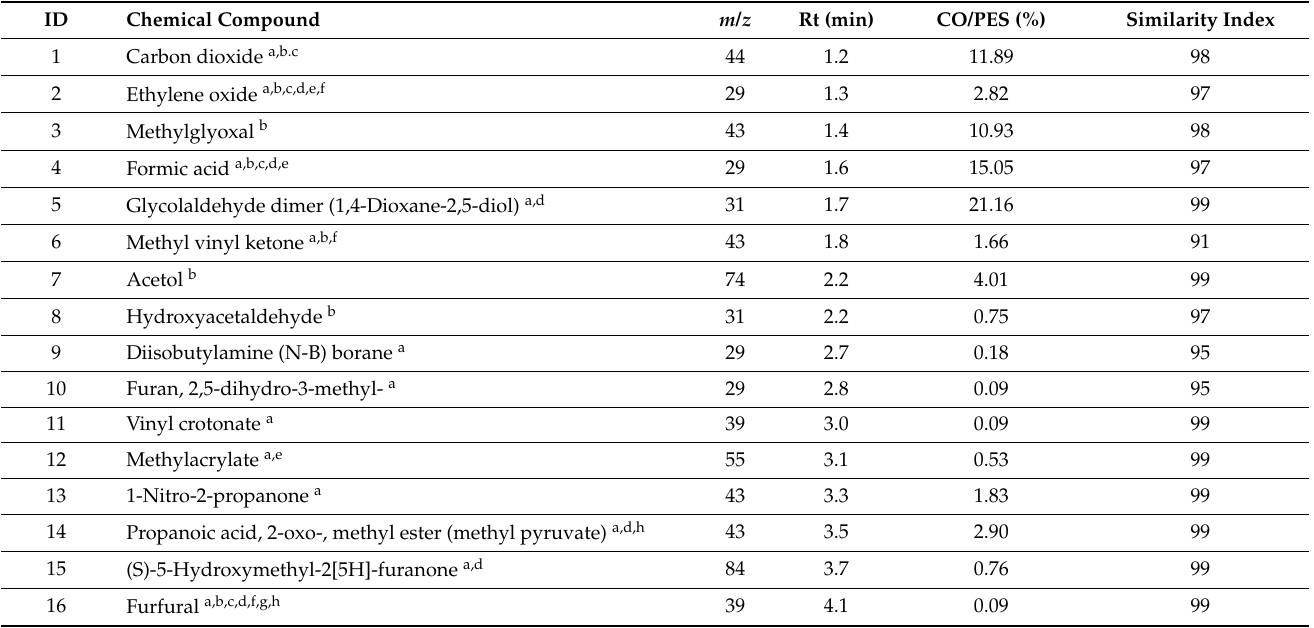
Figure 6. Chromatogram of cotton cellulose (weft yarn). Table 5. Pyrolytic products and quantitative indicators of the CO/PES composite fabric.